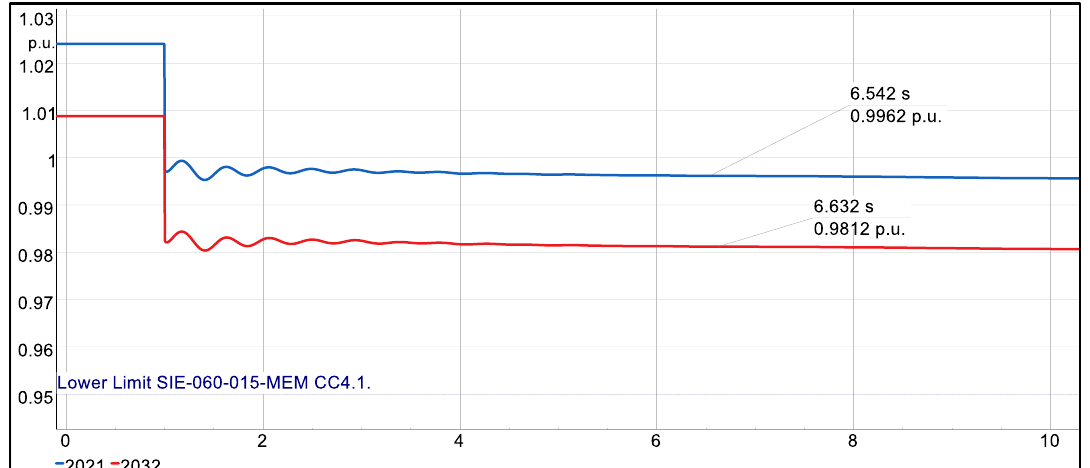
Figure 11. Comparison of voltages in the system when a large load enters between 2021 and 2032.